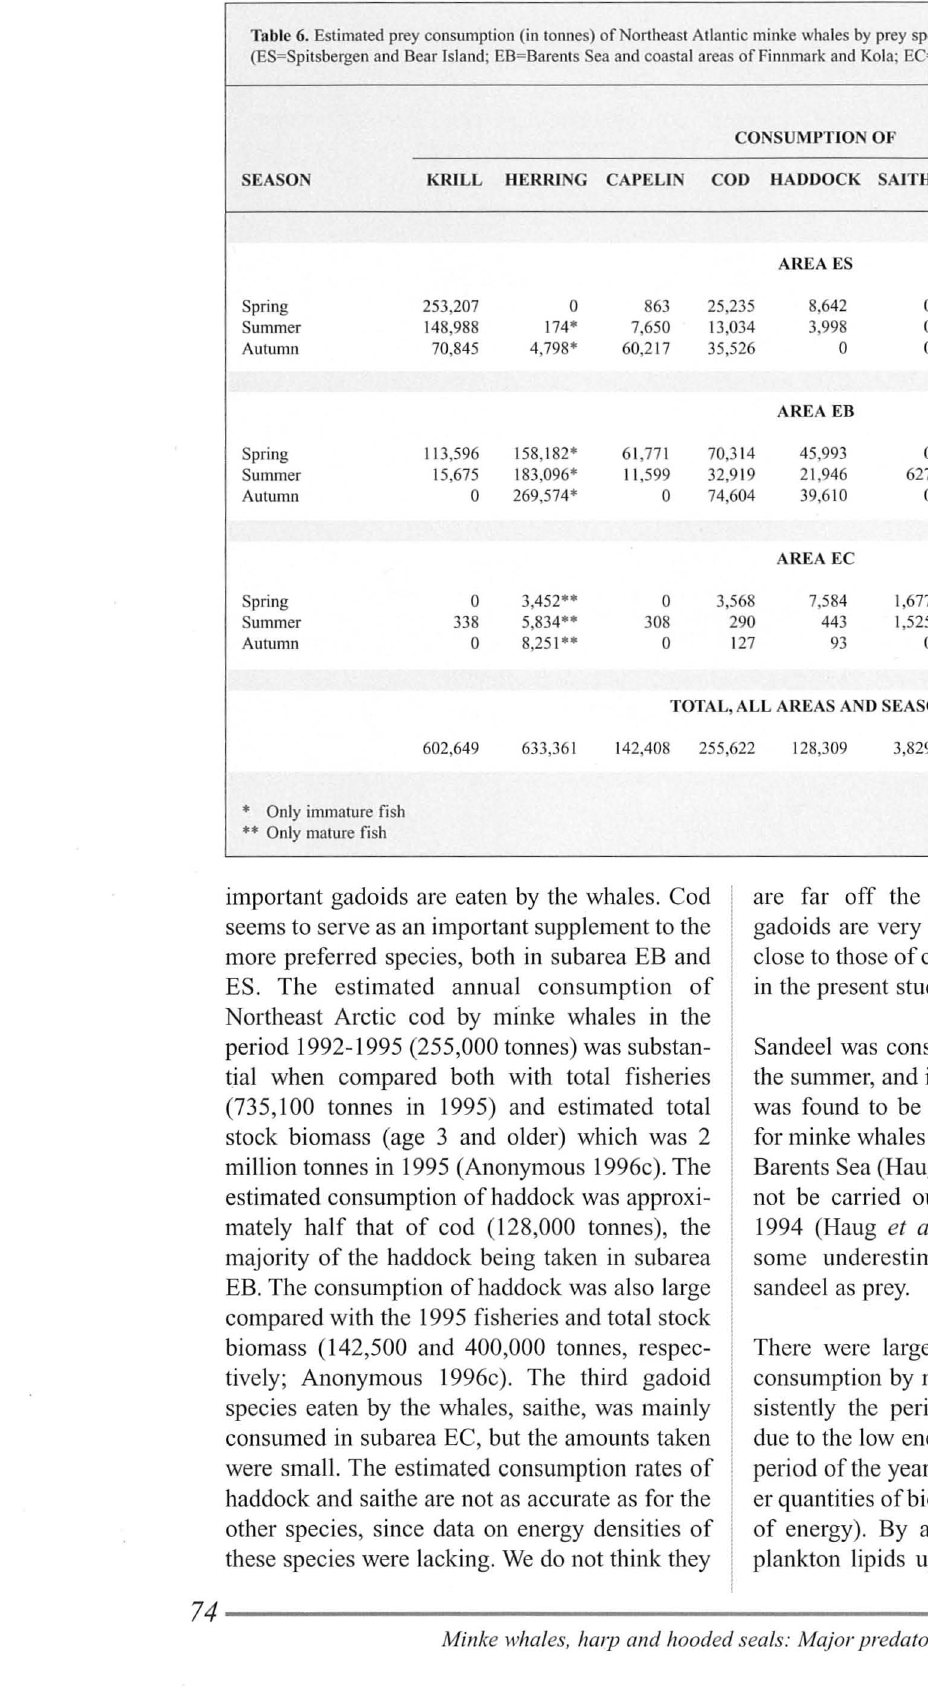
Table 6. Estimated prey consumption (in tonnes) of Northeast Atlantic minke whales by prey species, geographical subarea (ES=Spitsbergen and Bear Island; EB=Barents Sea and coastal areas of Finnmark and Kola; EC=VesterAlen and Lofoten) and season.